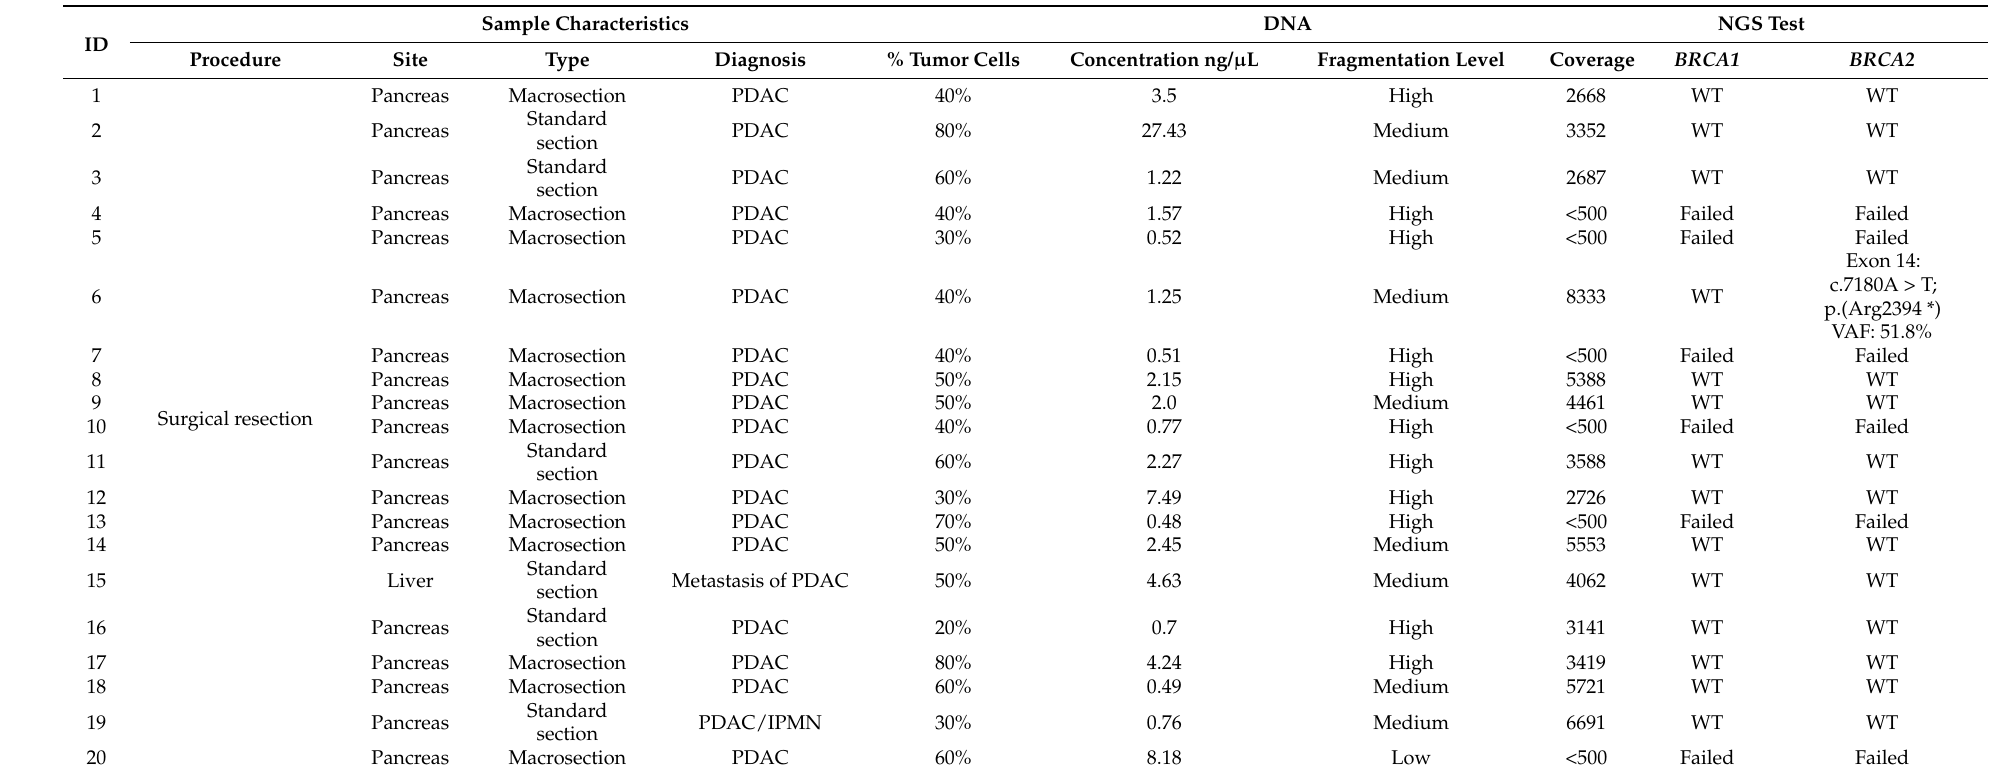
Table 1. BRCA1/2 testing